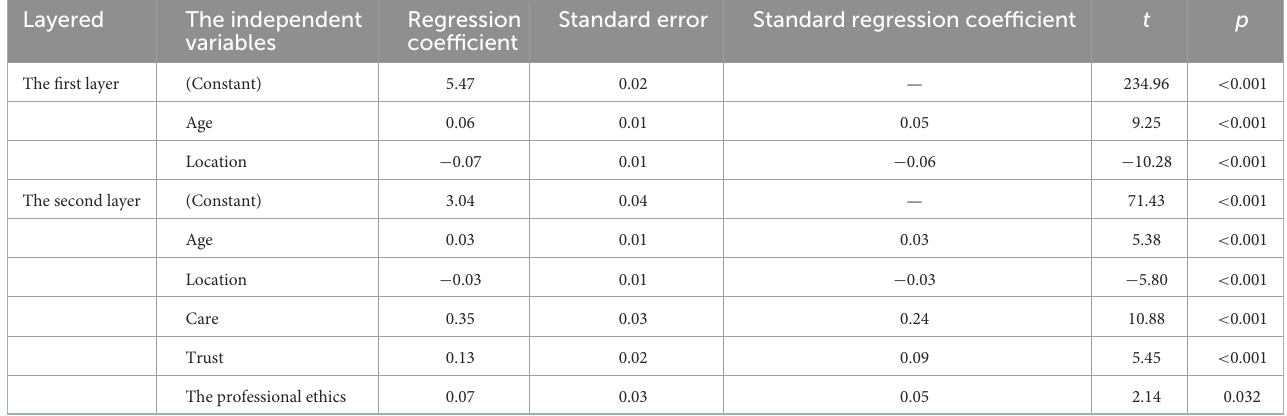
TABLE 4 Hierarchical linear regression analysis of nursing relationship satisfaction ( n = 29,108).